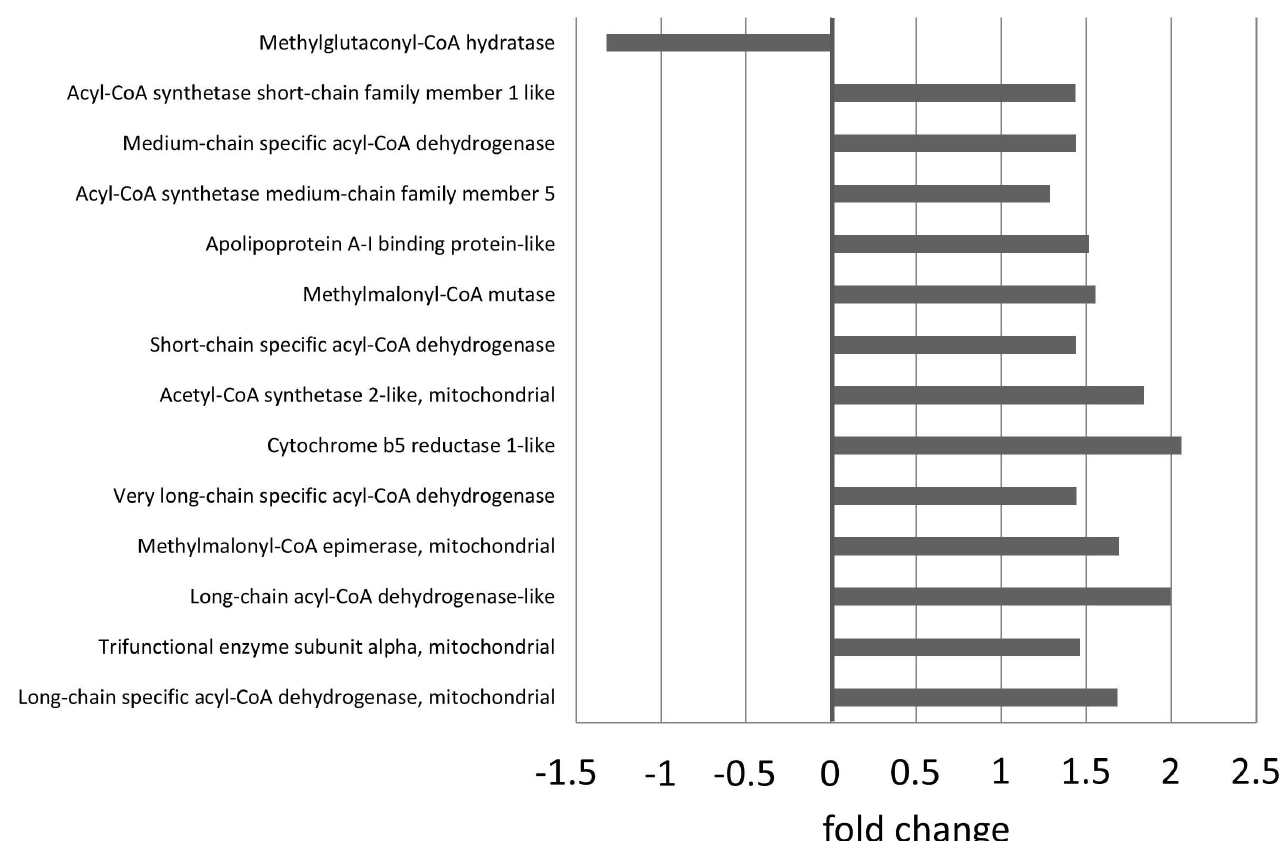
Fig 4. VPI-induced expressionchanges of enzymesbelonging to the fatty acid